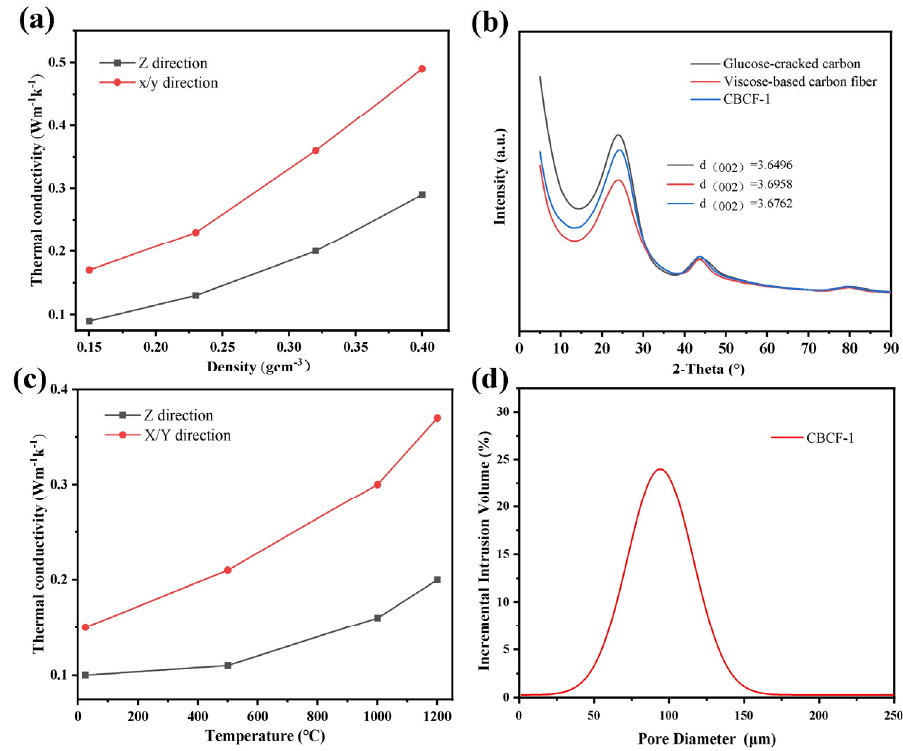
Figure 7. ( a ) Thermal conductivity of CBCF ‐ 1, CBCF ‐ 2, CBCF ‐ 3, and CBCF ‐ 4; ( b ) high temperature thermal conductivity of CBCF ‐ 1; ( c ) XRD patterns of glucose ‐ cracked carbon; and ( d ) pore ‐ size distribution of CBCF ‐ 1.